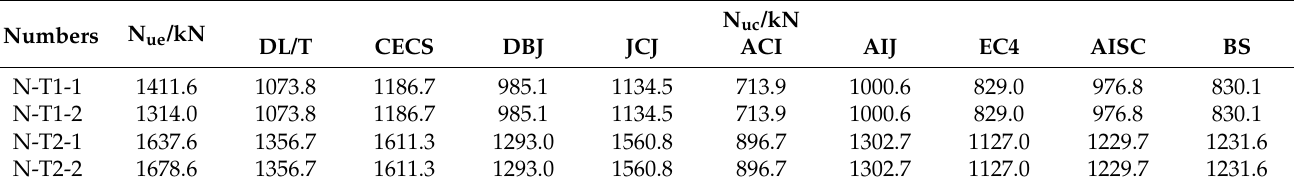
Table 3. The ultimate loads from experiments and theoretical values using different design codes of the SCCFTST